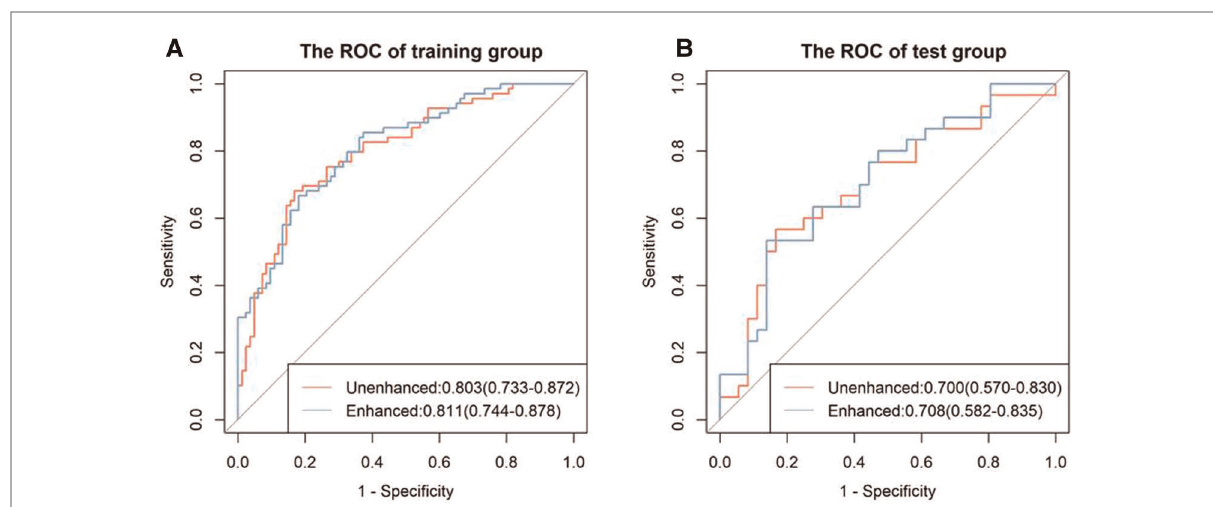
FIGURE 7 ROC curves of the unenhanced and enhanced models. The left fi gure (A) shows the ROC curve of the training cohort, and the right fi gure (B) shows the ROC curve of the test cohort. There was no signi fi cant difference between the two models in the training and test groups (both p